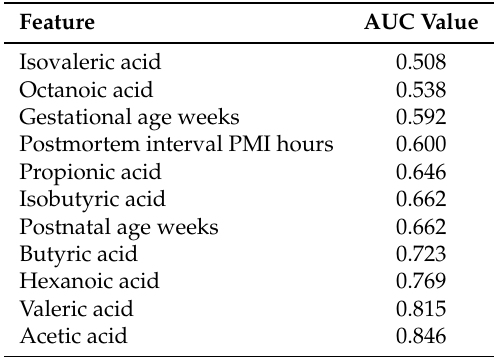
Table 2. AUC values obtained by each feature through the univariate analysis.